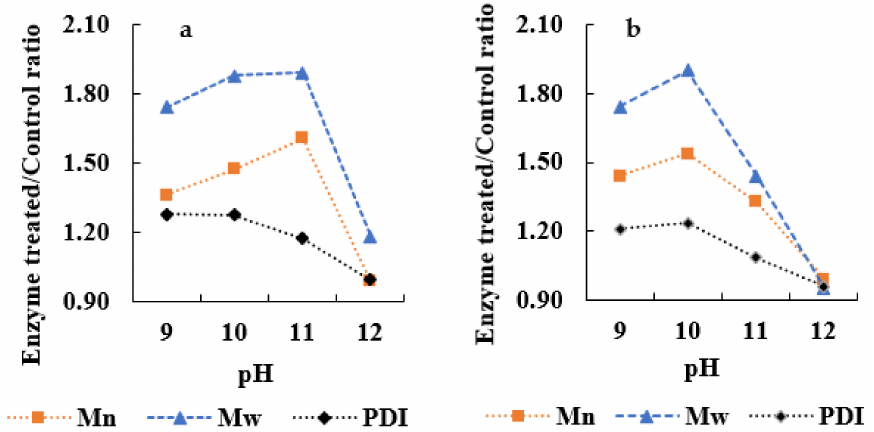
Figure 4. Average molecular weights (Mn and Mw) and PDI ratio of the APL with and without ScLac in ( a ) 0.4% NaOH and ( b ) 1% NaOH solutions at increasing pH (9, 10, 11, and